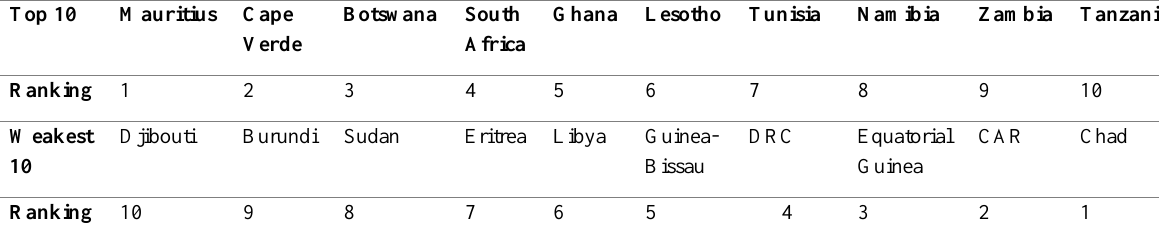
Table 1 : Best 10 and weakest 10 African democracies